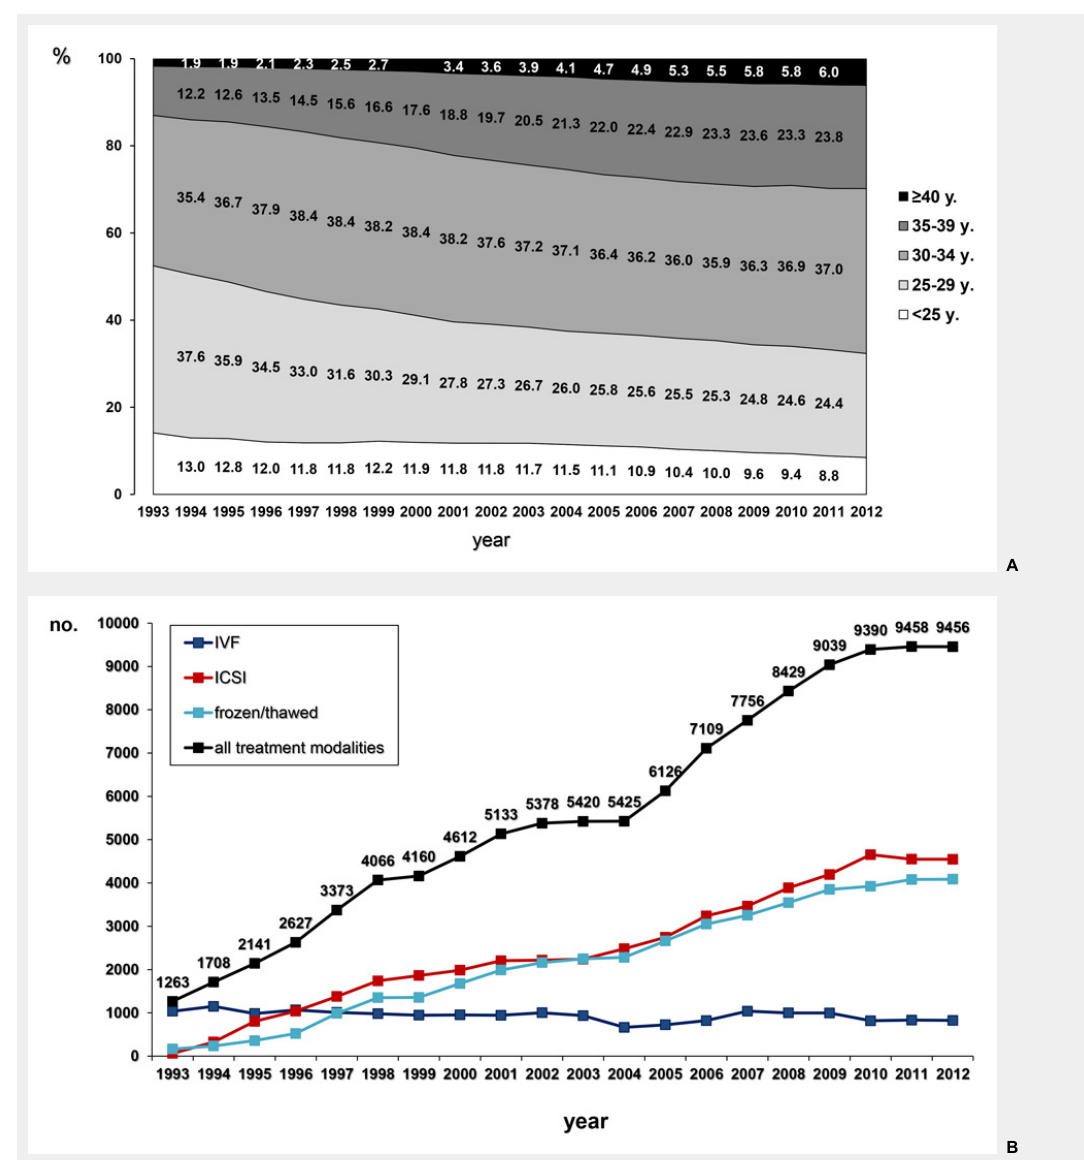
A Age of women giving birth in Switzerland between 1993 and 2012 was extracted from the data base constructed and published by the Swiss Federal Office of Statistics (BfS). During this observation period the proportion of women giving birth at the age of 35 to 39 years or older has nearly doubled, whereas the age of women giving birth at the age of 40 years or older has risen more than threefold. B During the observation period between 1993 and 2012 the number of treatments with ART, including IVF, ICSI and the transfer of frozen/ thawed embryos and oocytes at the pronucleate stage, has risen almost continuously, as evidenced by the Swiss ART data registry, FIVNAT-